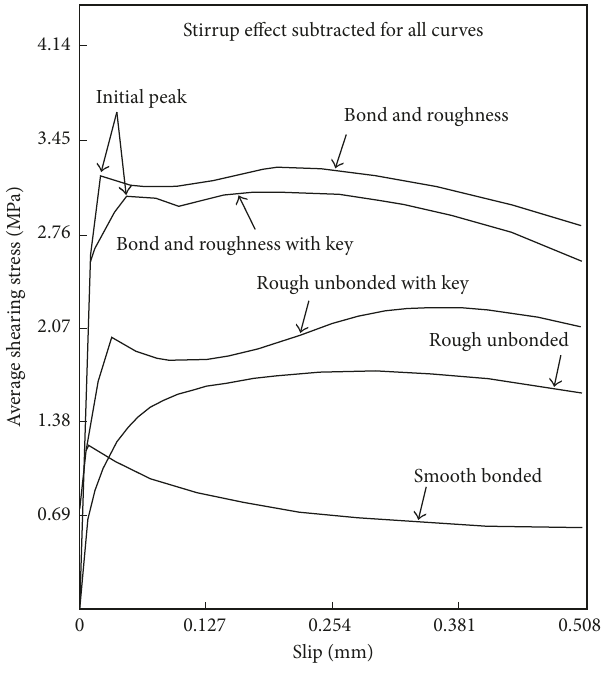
Figure 8: Typical shear-slip curves from Hanson [16].